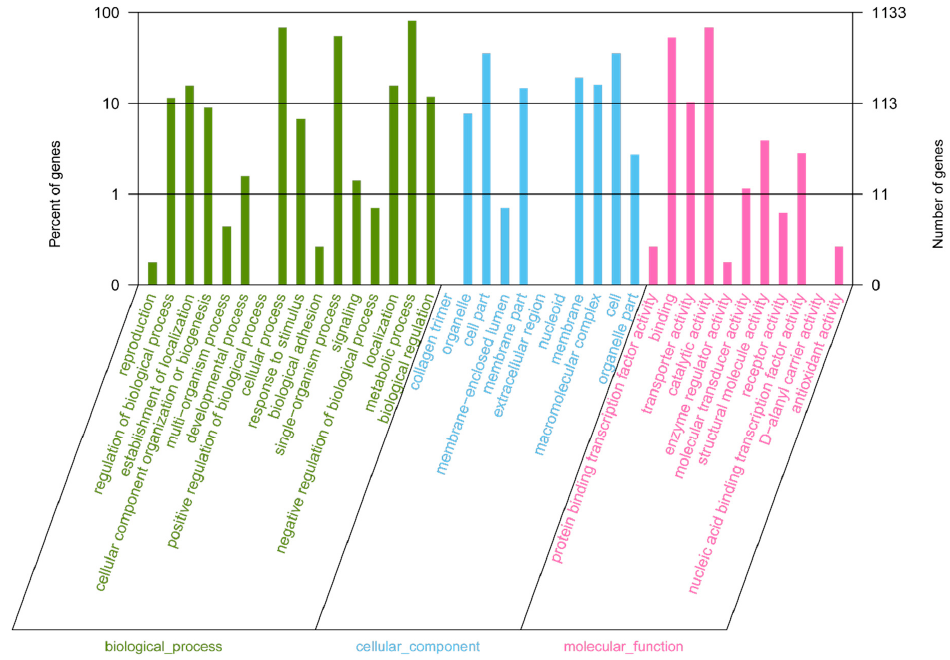
Figure 3. Gene Ontology (GO) annotation classification statistics of the Leu. mesenteroides DRP105 genome.